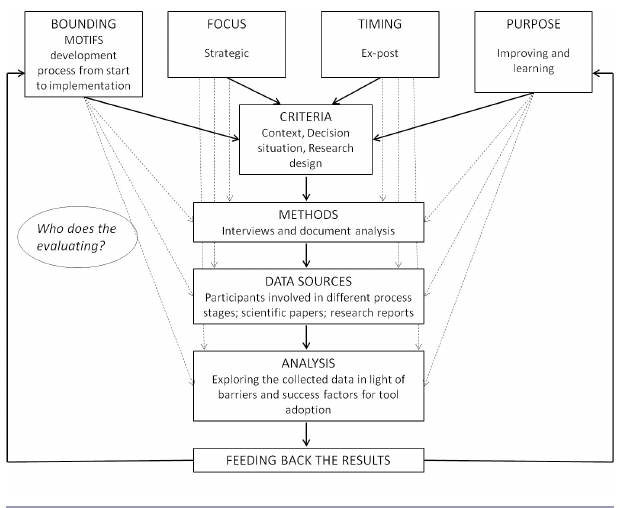
Fig. 1 . Reflection framework for the MOTIFS case, based on Blackstock et al.